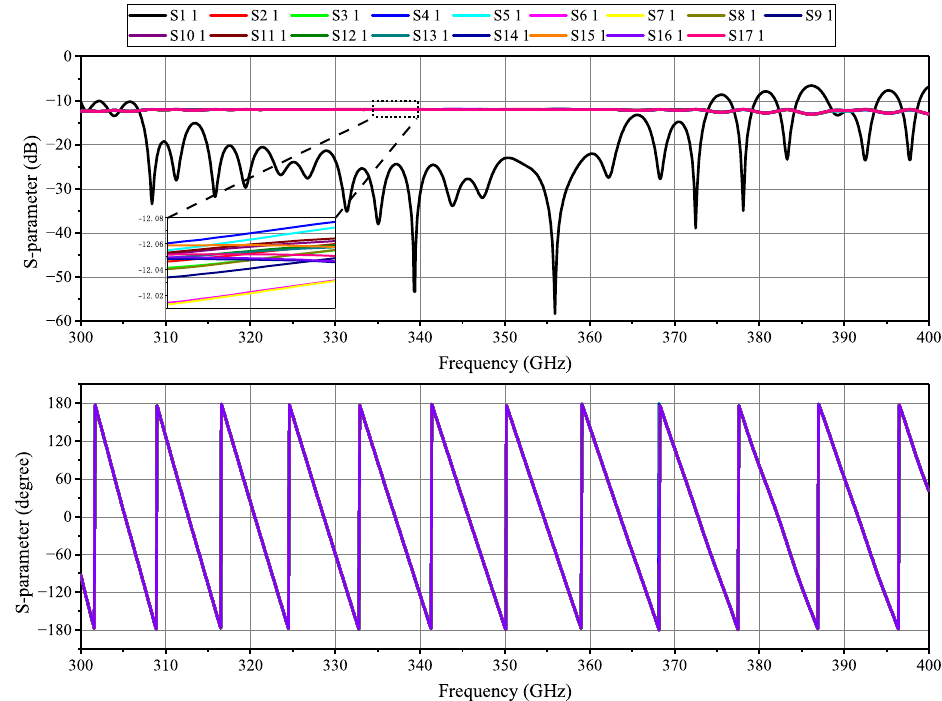
Figure 10. The S-parameters simulation results of the designed 16-way power